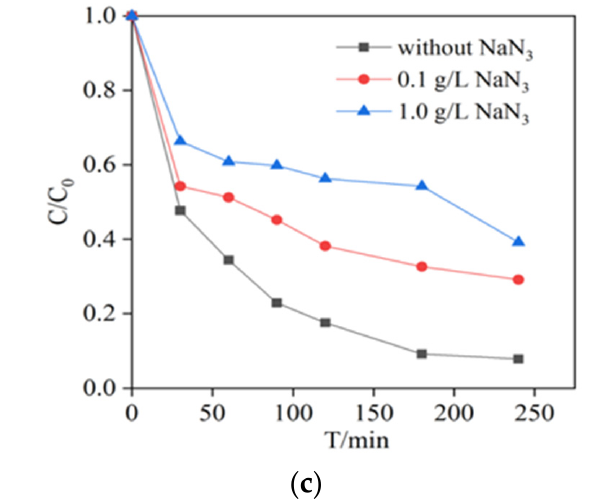
Figure 5. Effect of different ( a ) TBA, ( b ) MeOH and ( c ) NaN 3 concentration on degradation of PCA by PDS catalyzed with MnFe 2 O 4 .Experimental conditions: [PCA] = 20 mg/L, [PDS] = 2.4 mM, [MnFe 2 O 4 ] = 1.3 g/L and T = 25 °C.